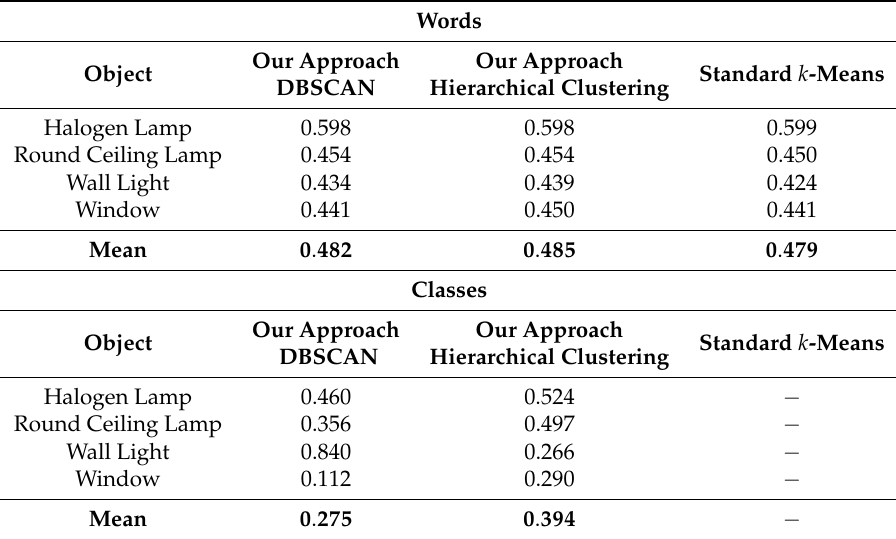
Table 1. Normalized entropy of the object classification into classes or words.